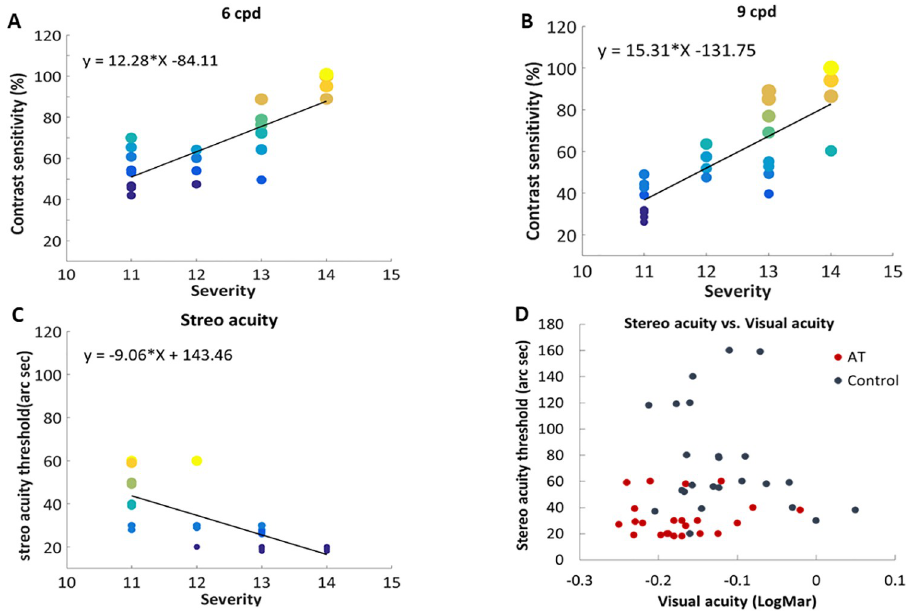
Fig 3. Correlation of visual performances. (a) . Correlation between contrast sensitivity (%) at 6 cpd and the severity rate (the last place where the subject made an error) of the red-green deficiency. Line, linear regression. The dot’s diameter is scaled by frequency and dots are further colored for clarity (b) . Correlation between contrast sensitivity (%) at 9 cpd and the severity rate (the last place where the subject made an error) of the red-green deficiency. Line, linear regression. The dot’s diameter is scaled by frequency and dots are colored for clarity. (c) . Correlation between the stereo acuity threshold (arc sec) and the severity rate (the last place where the subject made an error) in the red-green deficiency. Line, linear regression. The dot’s diameter is scaled by frequency and dots are colored for clarity. (d) . Correlation between visual acuity and the stereo acuity threshold (arc sec) in all anomalous trichromat and control